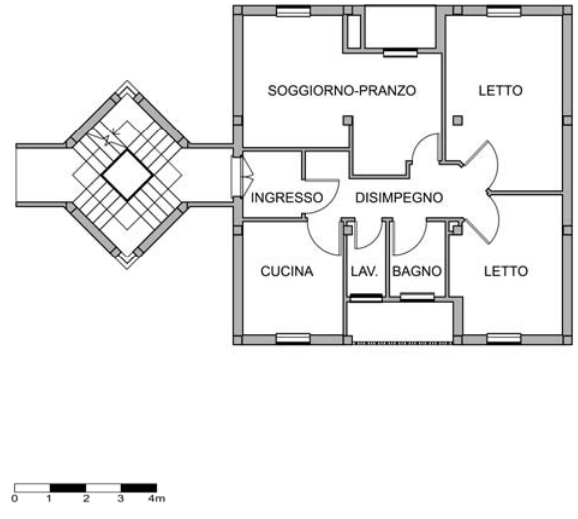
Figure 3. Plan of the typical five rooms